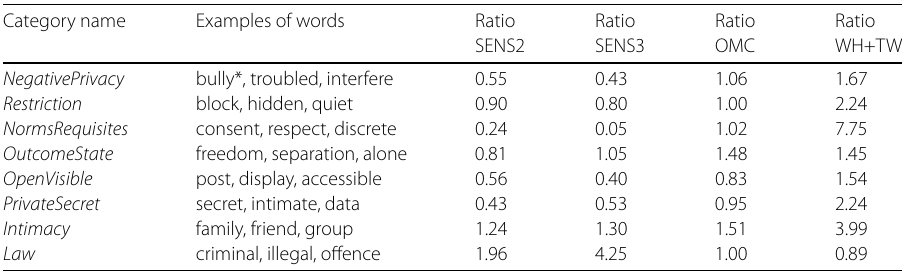
Table 9 Categories of the Privacy Dictionary [26]